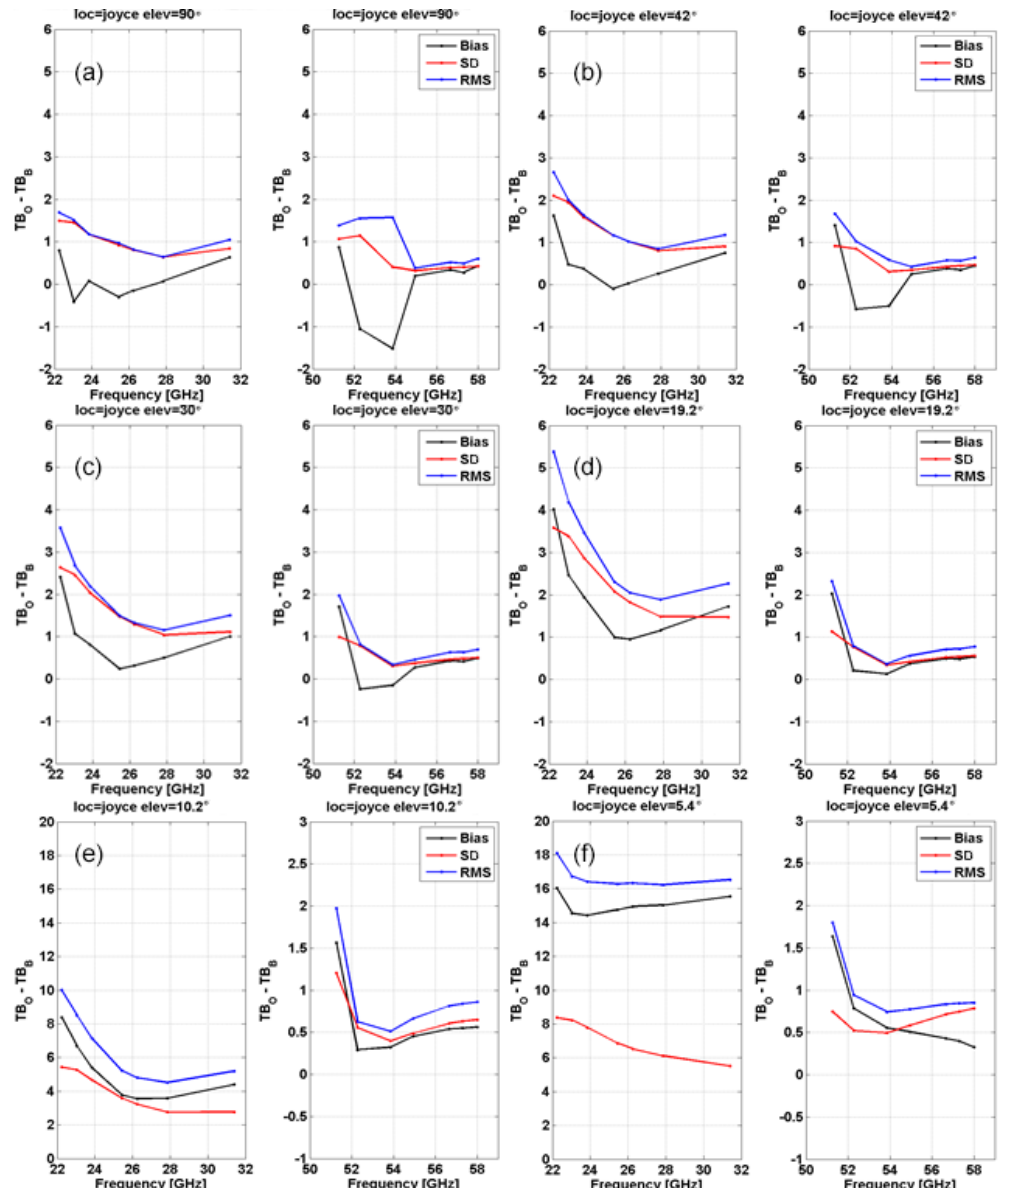
Figure 5. Statistics of the differences between observations and background TB, as in Fig. 3. Here, results from JOYCE at different observing angle are shown. Panels (a) , (b) , (c) , (d) , (e) , and (f) refer, respectively, to 90, 42, 30, 19.2, 10.2, and 5.4 ◦ elevation angle. Biases are shown with black lines, standard deviations with red lines, and RMS with blue